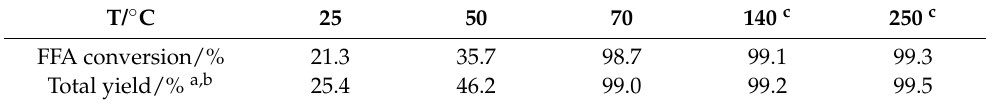
Table 3. The influence of the reaction temperature on the